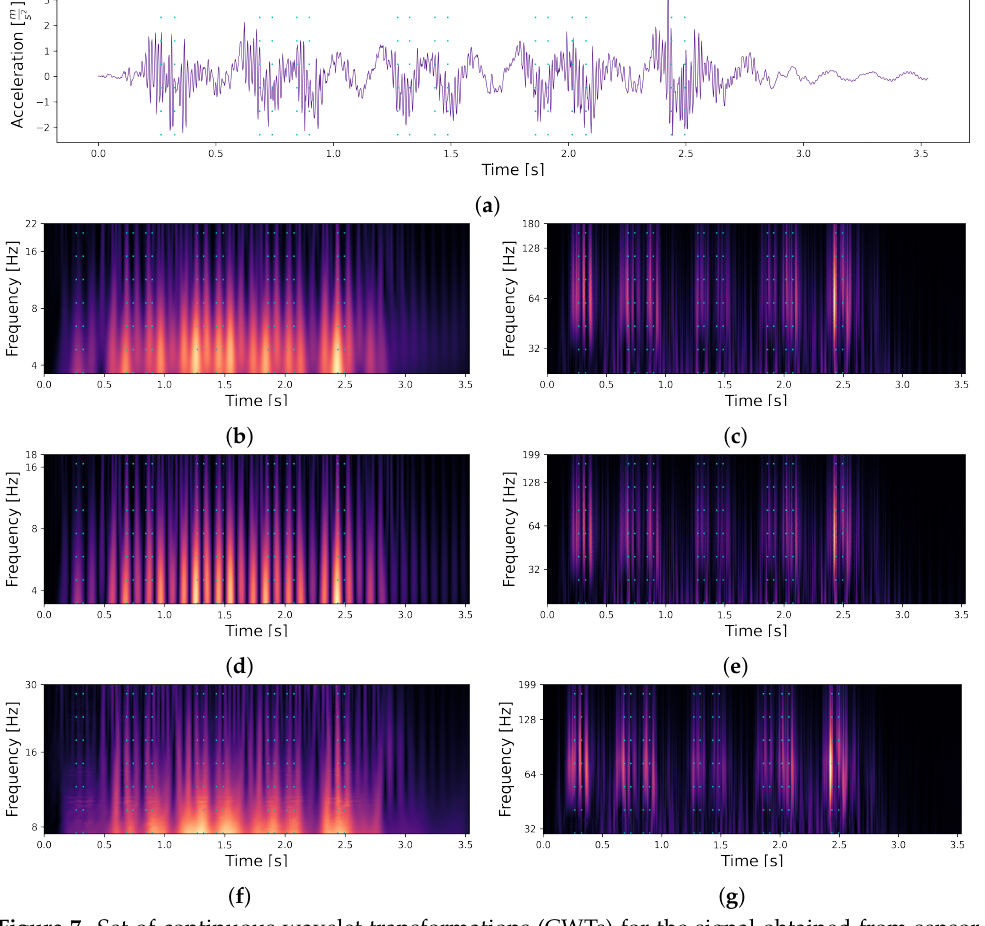
Figure 7. Set of continuous wavelet transformations (CWTs) for the signal obtained from sensor L2 for one of the train passages. The point in time when a load transition occurs is represented by a dashed line in cyan. Each of the transformations were independently normalised from 0 to 1 (visualised with black for 0 and yellow for 1). ( a ) Acceleration signal of a single train passage. ( b ) Complex Gaussian CWT in frequency range of bridge. ( c ) Complex Gaussian CWT in frequency range of axles. ( d ) Gaussian CWT in frequency range of bridge. ( e ) Gaussian CWT in frequency range of axles. ( f ) Frequency B-Spline CWT in frequency range of bridge. ( g ) Frequency B-Spline CWT in frequency range of